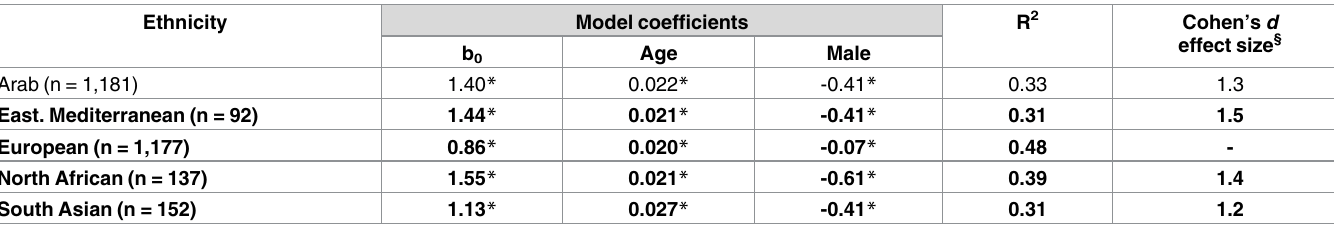
Table 1. SAF model comparison for different ethnic